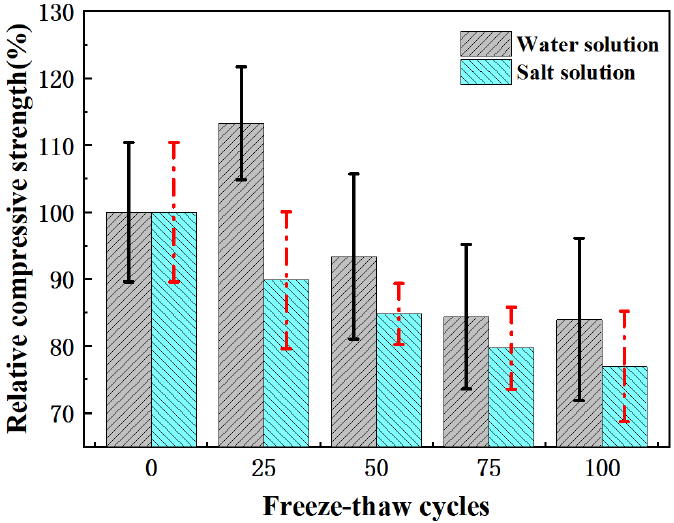
Figure 6. Relative strength change of pervious concrete under freeze-thaw cycles. Dynamic Elastic